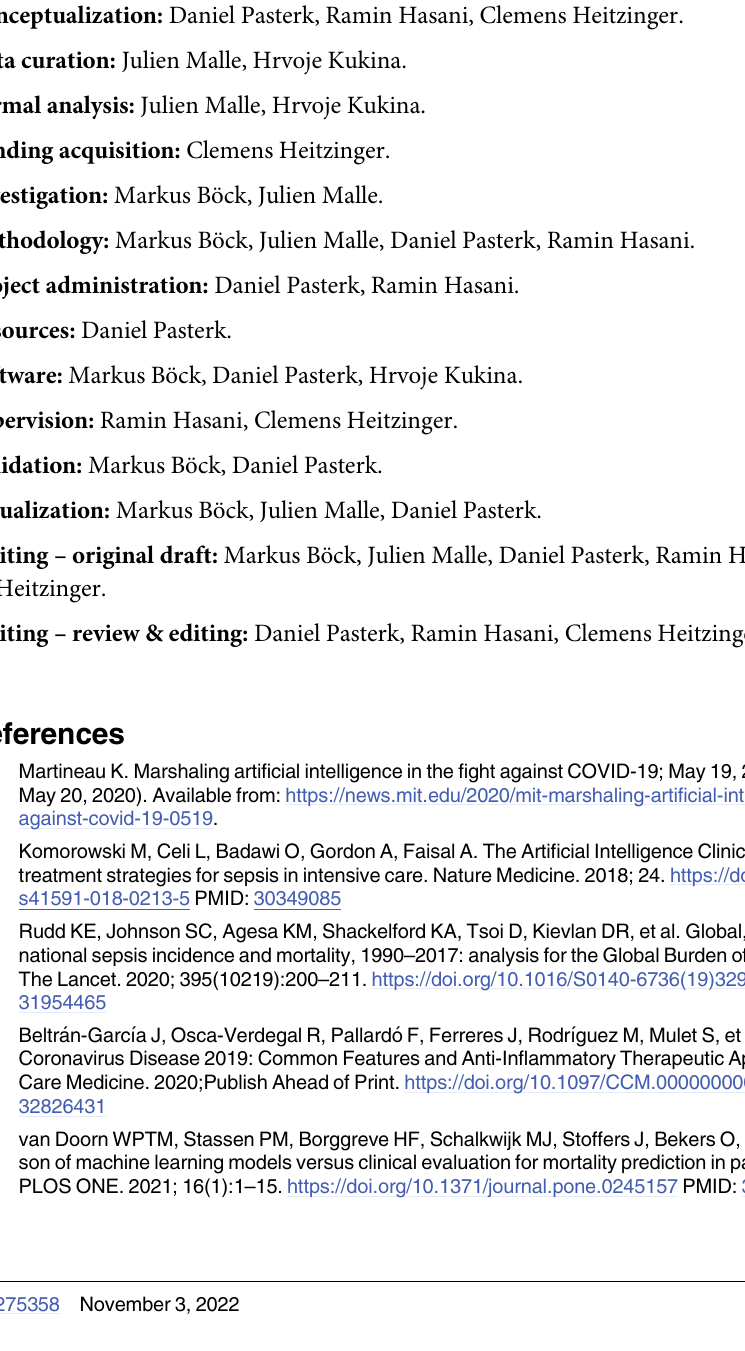
S4 Fig. Comparison between mean imputation, kNN, and SVT for multiple dimensions of the orthonormally mapped data. Although SVT gives an almost perfect recovery for very high dimensions, it performs very poorly (worse than mean imputation!) in low dimensions. On the other hand, the kNN recovery is always better (in terms of RSSE) than the mean impu- tation. S1 Table. Medical features extracted from raw